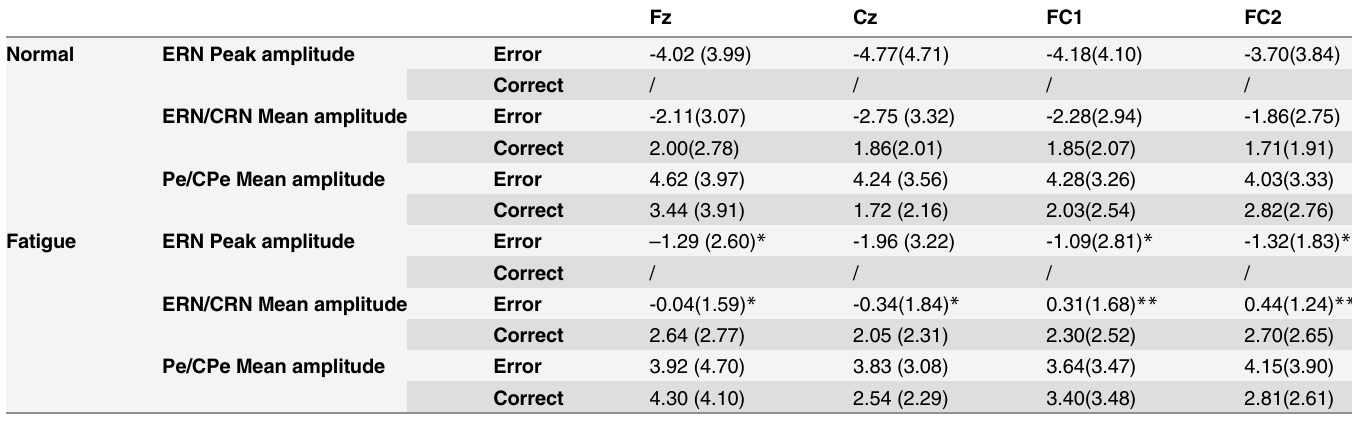
Table 5. Average ERN peak, ERN/CRN mean, and Pe/CPe mean amplitudes under the normal or fatigue condition.